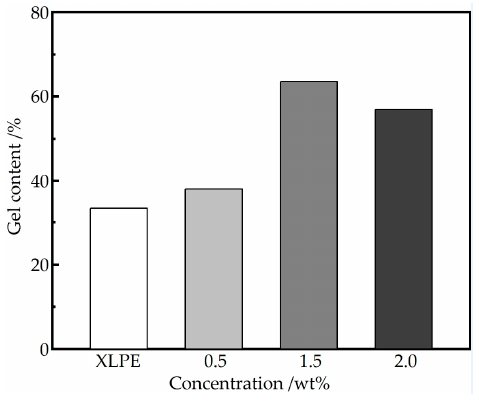
Figure 5. Gel contents of TAIC- s -SiO 2 /XLPE nanocomposites versus the filling concentration of Table 2. nanoparticles, through crosslinking reaction under UV irradiation for 300 s.